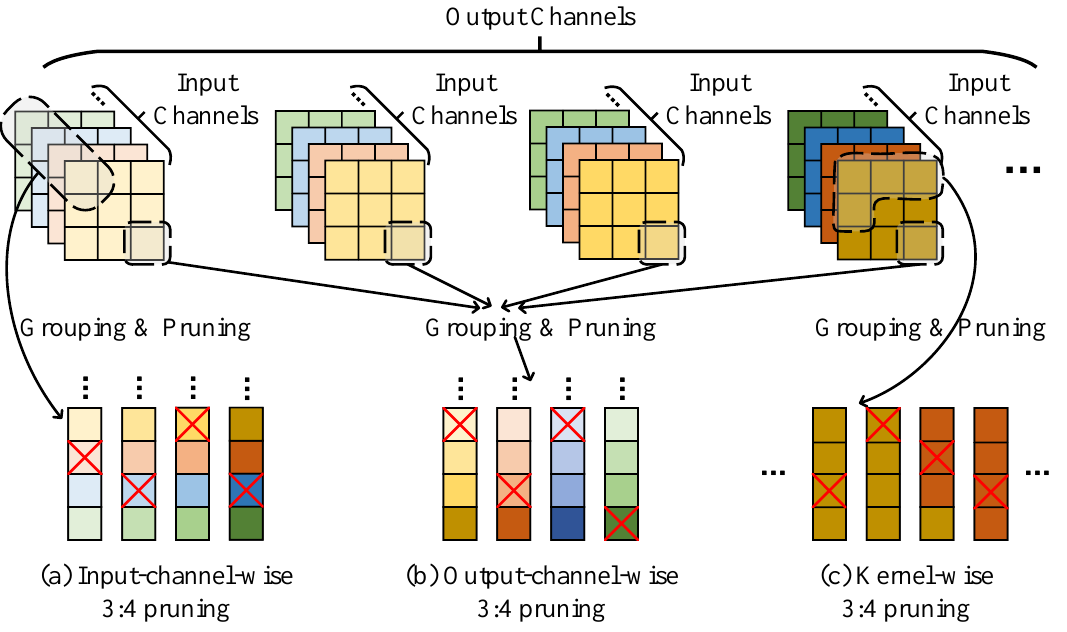
Figure 1. An example of convolution weights and 3:4 pruning in different convolutional dimensions. For input-channel-wise pruning, the weights with the same positions in different input channels in the same filter are flattened and converted into a one-dimensional